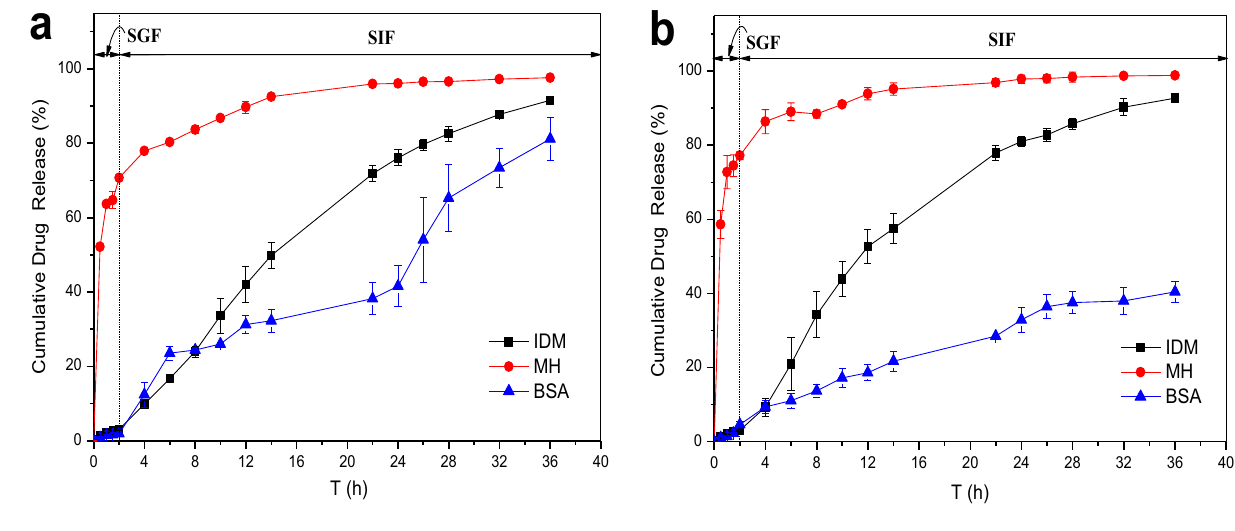
Figure 11. Effect of outer-layer materials type on the cumulative drug release behavior of double layer hydrogels in SBF [( a ) SA-CMC@PDMA-1; ( b ) SA-CMC@PAA-1].